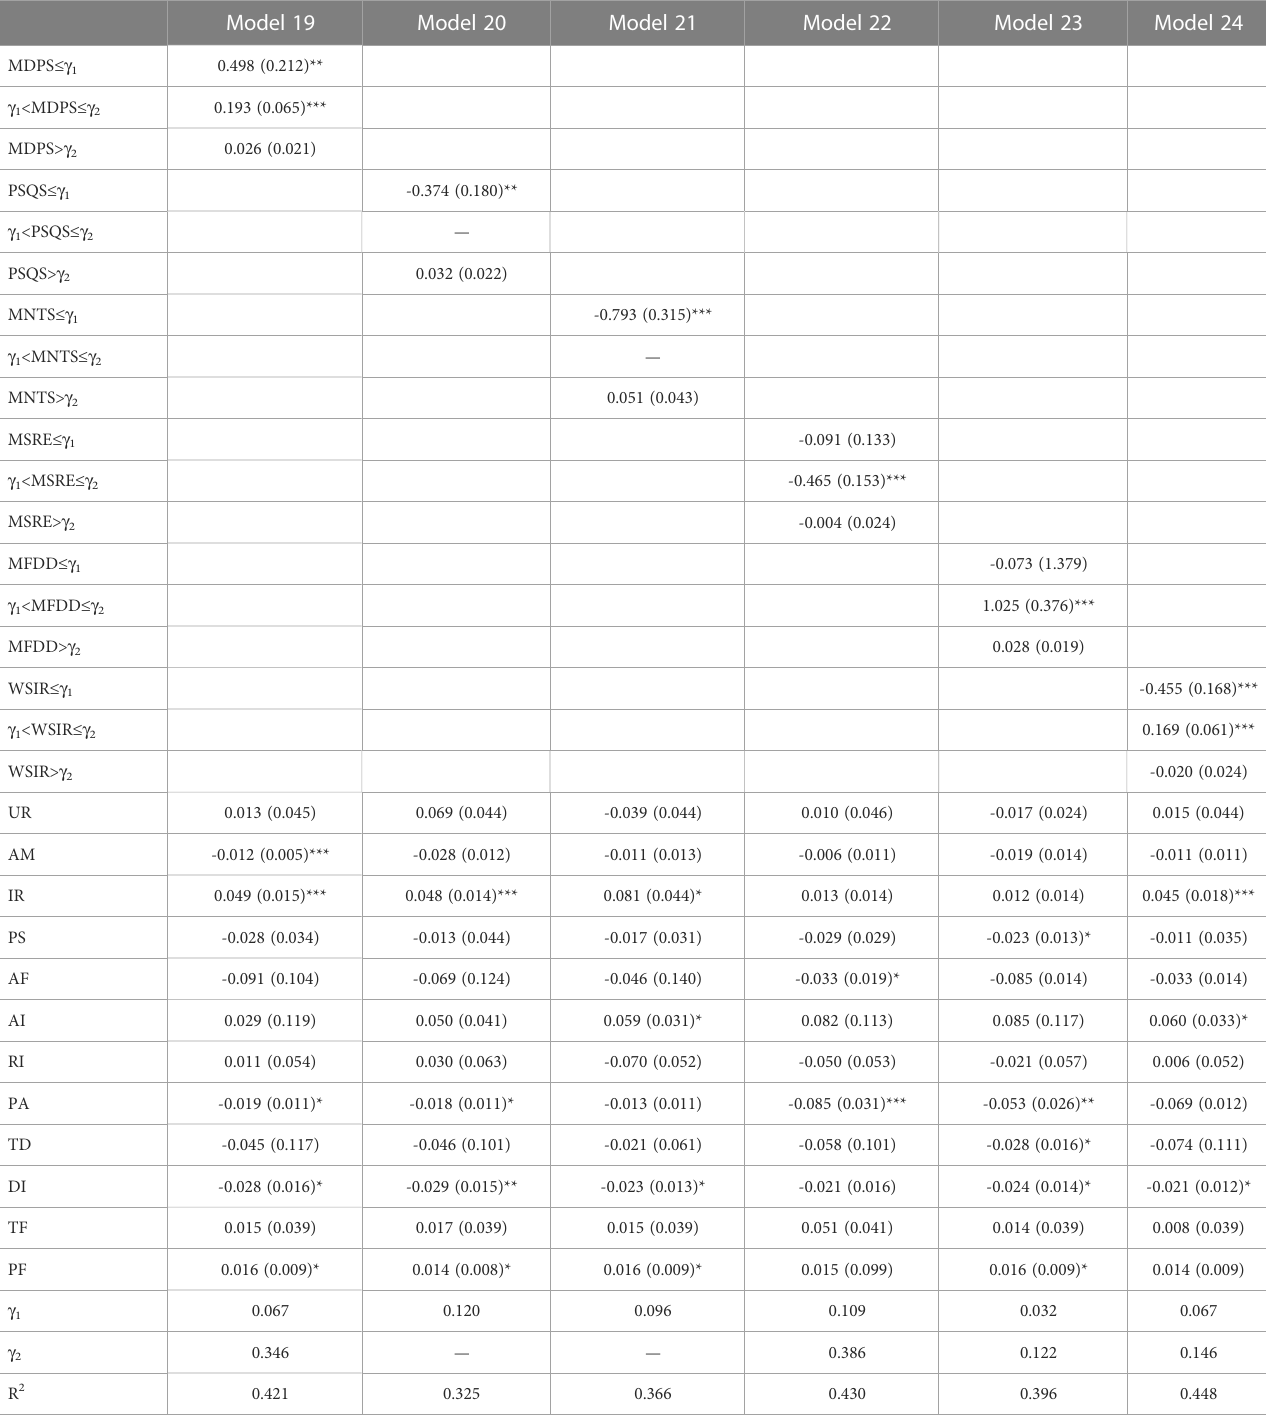
TABLE 4 The threshold model results of GECG in the whole